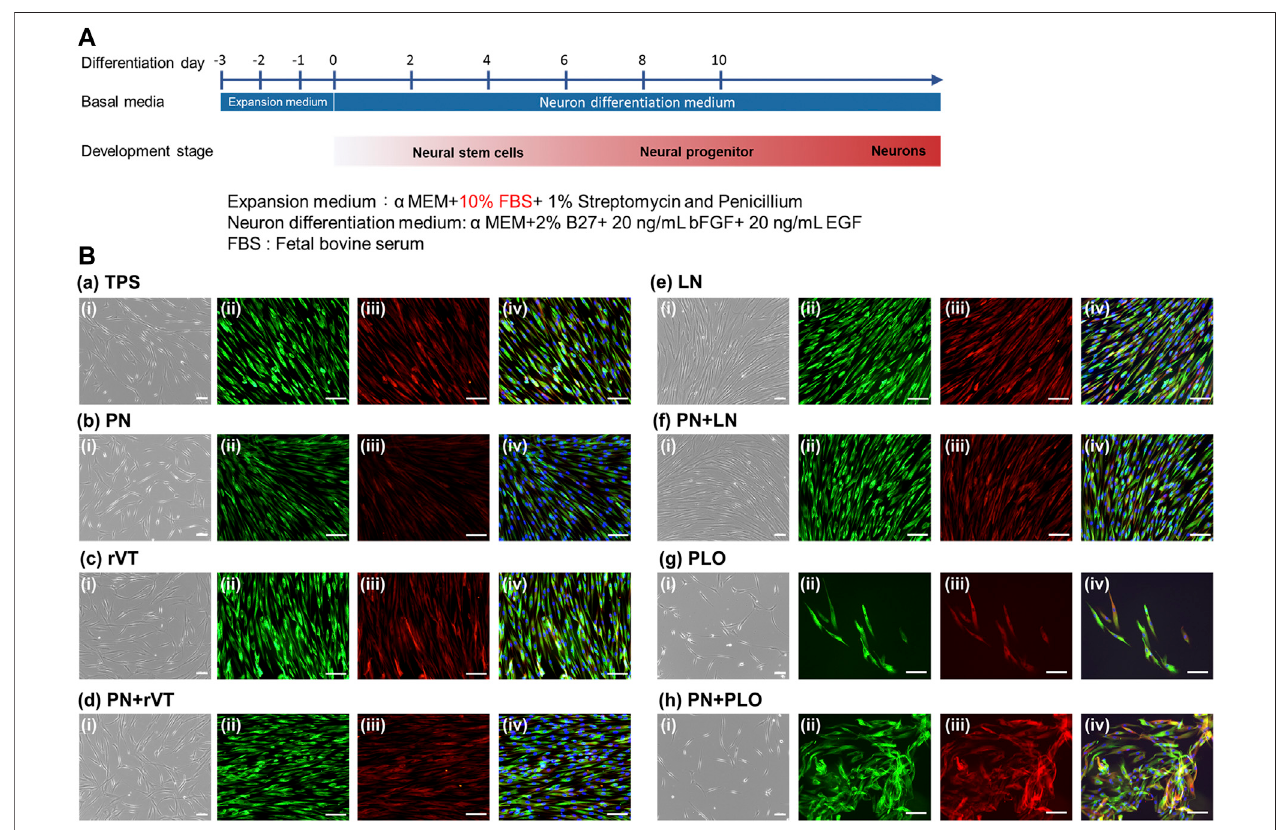
FIGURE 5 | Differentiation of DPSCs into neuronal cells after fi ve passages of cultivation on TPS, TPS-PN, TPS-ECM, TPS-PLO, TPS-PN-ECM and TPS-PN-PLO plates. (A) The timeline of the induction of DPSCs differentiation into neuronal cells. (B) The morphologies of DPSCs-derived neuronal cells (i) and the immunohistochemical assay of β III-tubulin [ (ii) , green] and nestin [ (iii) , red)] expression on the TPS (a) , TPS-PN (b) , TPS-rVT (c) , TPS-PN-rVT (d) , TPS-LN (e) , TPS-PN- LN (f) , TPS-PLO (g) and TPS-PN-PLO (h) plates. The photo (iv) was the merged photos of (ii) and (iii) . The scale bar indicates 100 μ m.